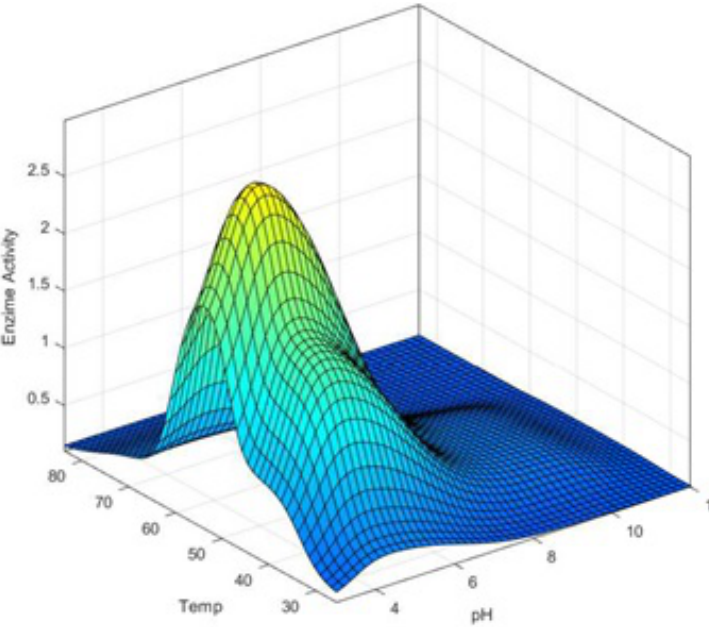
Figure 6. FIS output surface.